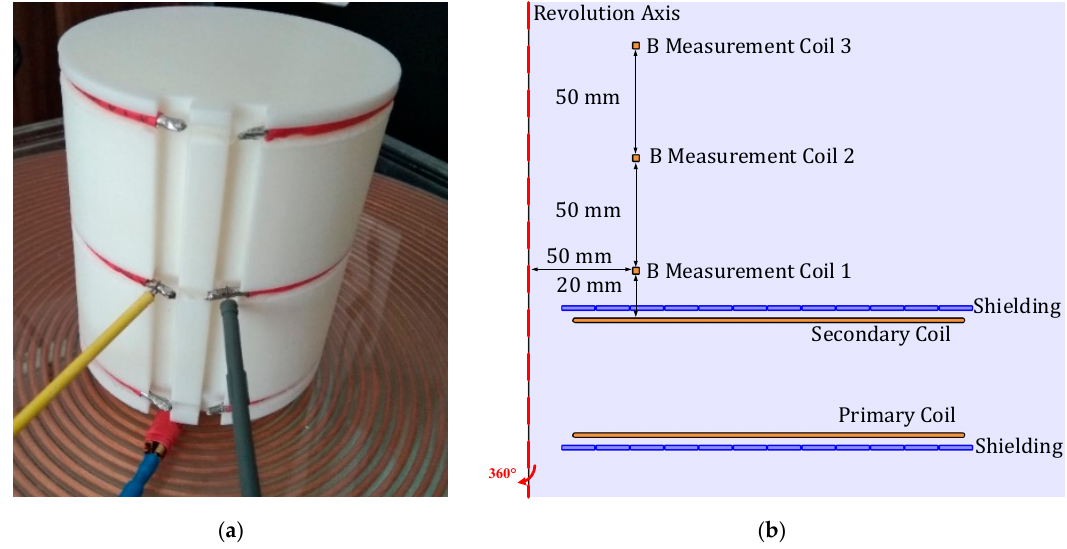
Figure 9. Measuring Coil for electromagnetic (EM) Field Radiation ( a ) and description of physical arrangement during measurement ( b ).